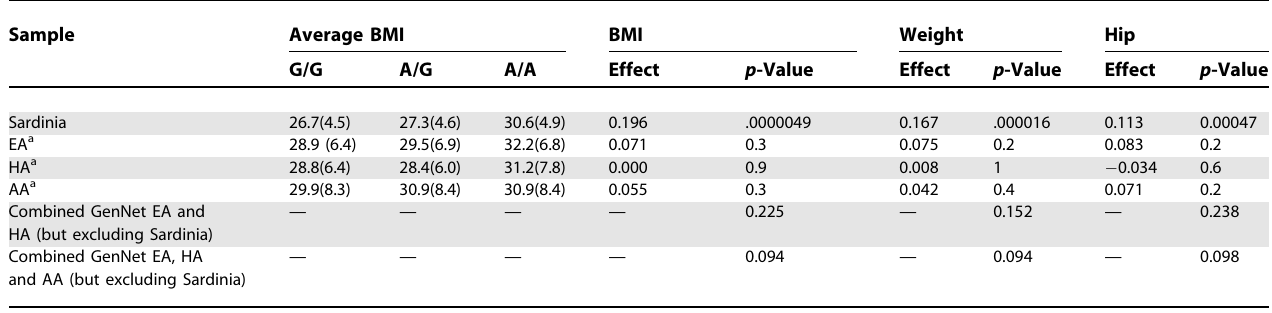
Table 5. Replication of Association between rs6602024/ PFKP /A Allele and Obesity-Related Traits